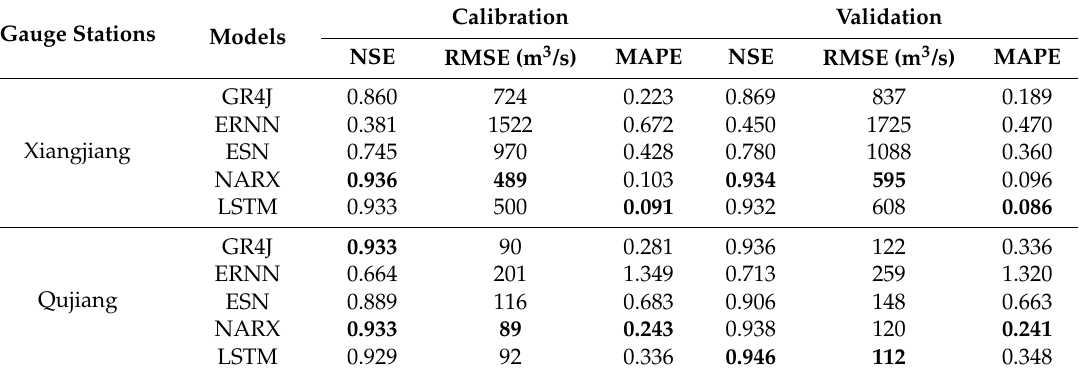
Table 2. Performance indicators of the hydrological model GR4J and different recurrent neural networks (RNNs). MAPE: mean absolute percentage error, NSE: Nash–Sutcliffe efficiency coefficient, RMSE: root mean square error.